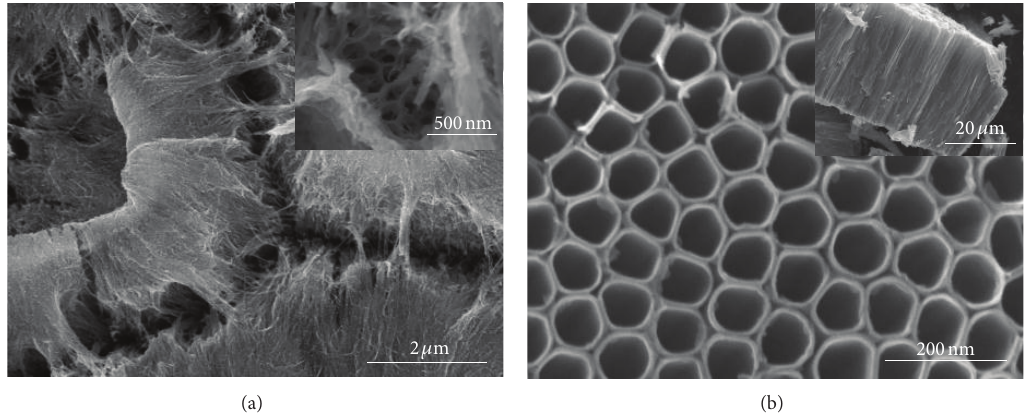
Figure 1: Top view SEM images of TiO 2 nanotube arrays (a) before and (b) after the ultrasonic treatment. The inset in (a) is the image with high magnification, while the inset in (b) shows the cross-sectional view of the nanotube arrays after ultrasonic treatment.